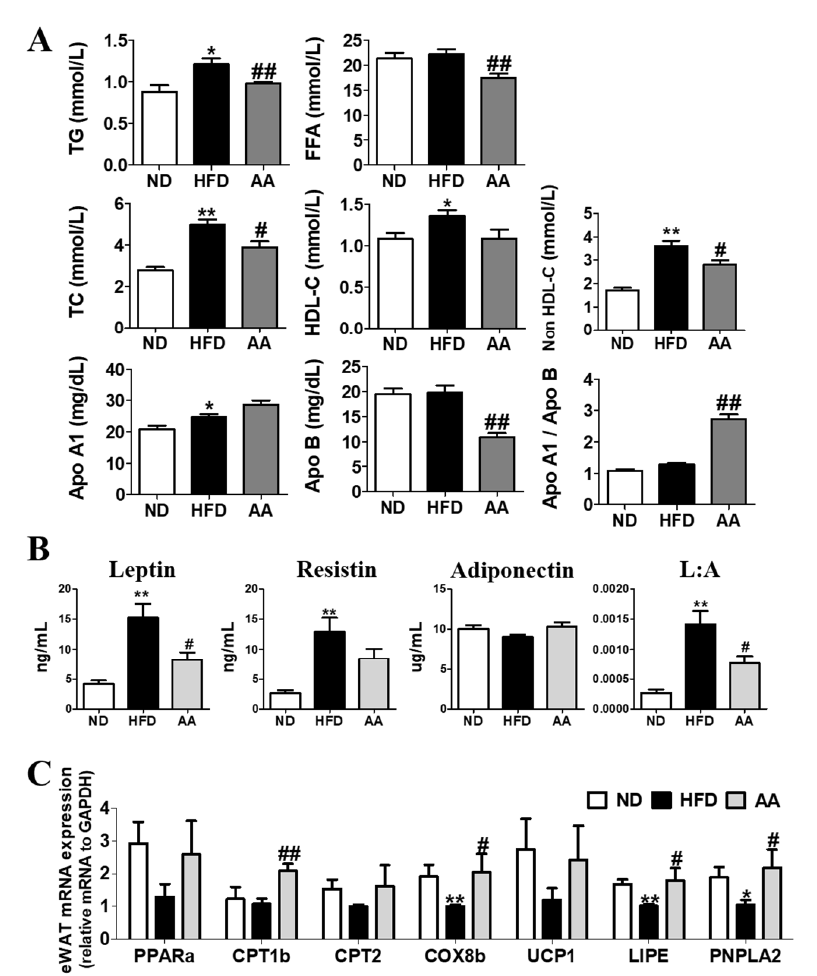
Figure 2. Effect of Artemisiae argyi water extract supplementation on diet-induced obesity. ( A ) Plasma lipid profiles, ( B ) plasma adipokine levels, and ( C ) mRNA expression of the epididymal WAT. Data are presented as the mean ± standard error of the mean. Significant differences between HFD and ND are indicated as * p < 0.05, ** p < 0.01. Significant differences between the HFD and AA groups are indicated as # p < 0.05, ## p < 0.01. ND, normal diet (AIN-93G, n = 10); HFD, high-fat diet (60% kcal from fat, n = 10); AA, HFD + A. argyi water extract (1.5%, w/w , n = 10); TG, triglyceride; FFA, free fatty acid; TC, total cholesterol; HDL-C, high density lipoprotein cholesterol; Apo A1, apolipoprotein A-1; Apo B apolipoprotein B; Apo A1/Apo B, Apo A1 and Apo B ratio; L:A, leptin and adiponectin ratio; PPARa, peroxisome proliferator activated receptor alpha; CPT1A, carnitine palmitoyltransferase 1A; CPT2, carnitine palmitoyltransferase 2; COX8b, cytochrome c oxidase subunit 8B; UCP1, uncoupling Protein 1; LIPE, hormone-sensitive lipase; PNPLA2, patatin-like phospholipase domain containing